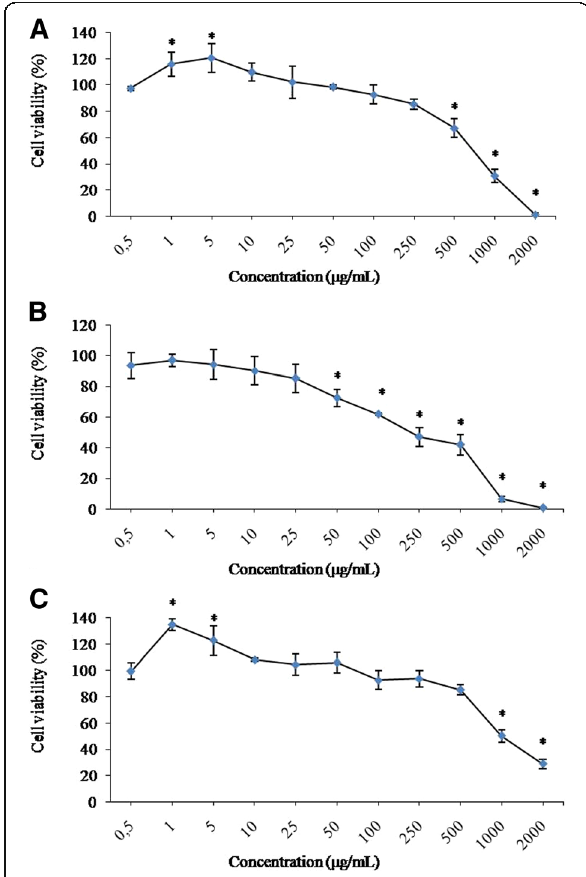
Fig. 3 Cytotoxicity of (+/ − ) catechins ( a ), gallocatechin ( b ) and rutin ( c ) in V79 cells. * p < 0.05, compared with negative control (0.5%